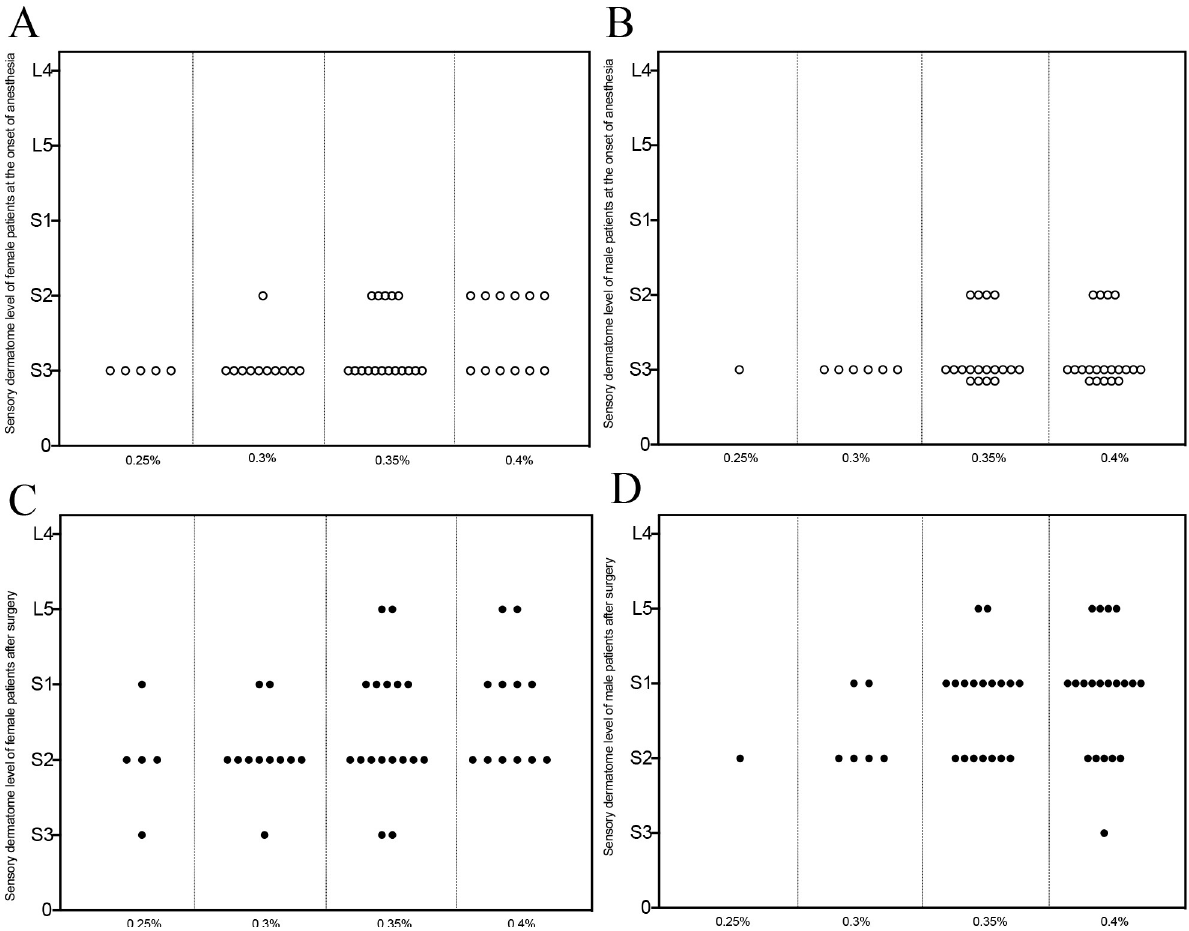
Fig 3. Sensory dermatome level of patients subjected to successful caudal block. Sensory dermatome level of female (n = 45, A and C) and male (n = 45, B and D) patients administrated with different volume of ropivacaine at the onset of caudal block (hollow circle in A and B) and at the end of surgery (solid circle in C and D). L: lumbar segment; S: sacral